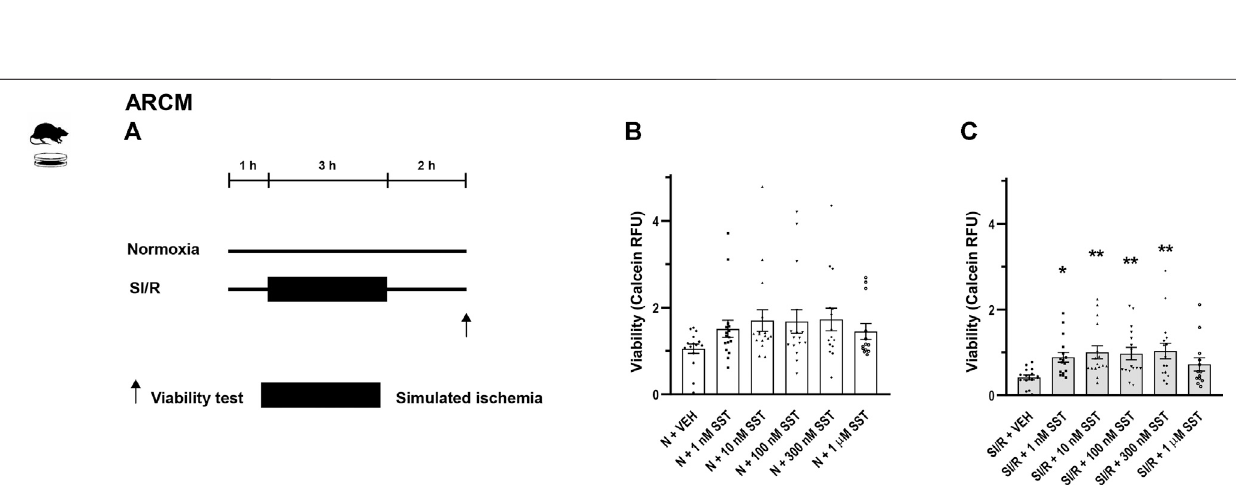
FIGURE 2 | In vitro simulated ischemia/reperfusion (SI/R) study protocol on isolated adult rat cardiomyocytes (ARCM) (A) . Somatostatin (SST) (1 nM, 10 nM, 100 nM, and 300 nM and 1 µM) or its vehicle (VEH) was added to the cells during the whole experiment. Viability of SST-treated ARCM cells exposed to normoxia (N) (B) orSI/R (C) .Dataarepresentedasmean ± SEM.TheKruskal-Wallistestand Dunn ’ sposthoctest, * p < 0.05;** p < 0.01vs.VEH fromfourindependentexperiments. RFU: relative fl uorescence